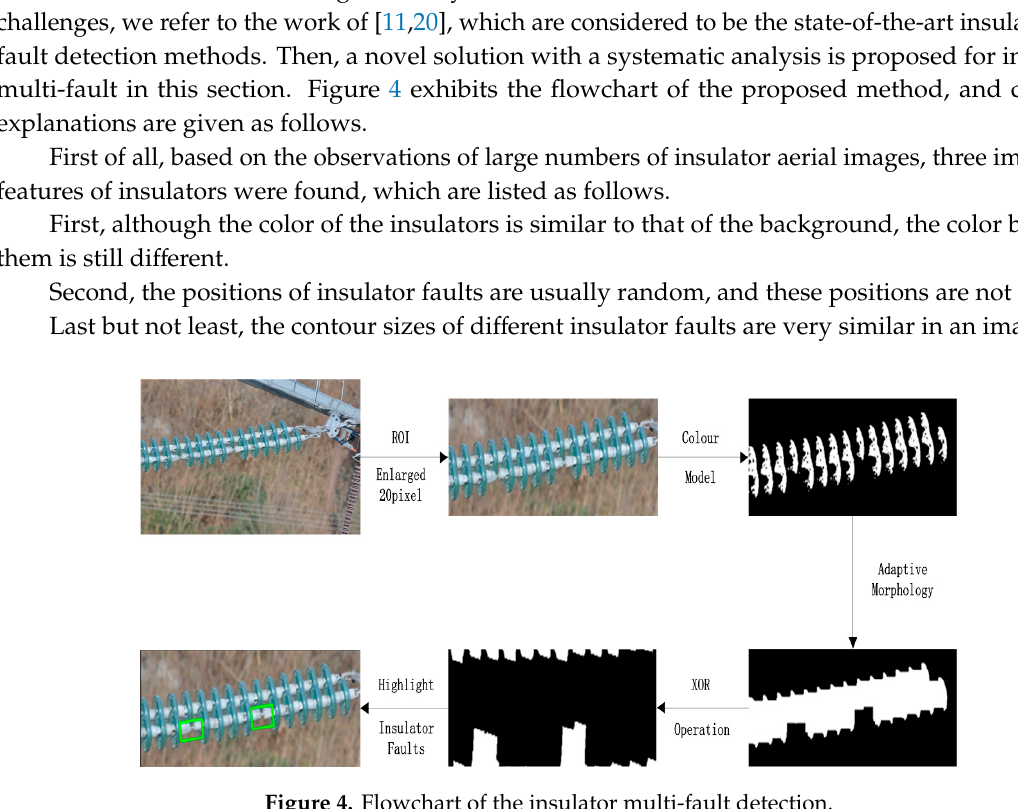
Figure 4. Flowchart of the insulator multi-fault detection.